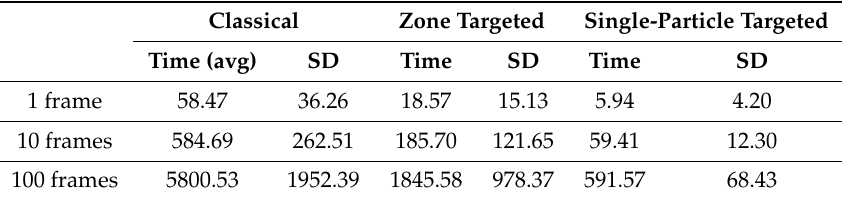
Table 5. Comparison of annotation time for different crowd work strategies. Time values are averaged and rounded to two decimal places and given in s.